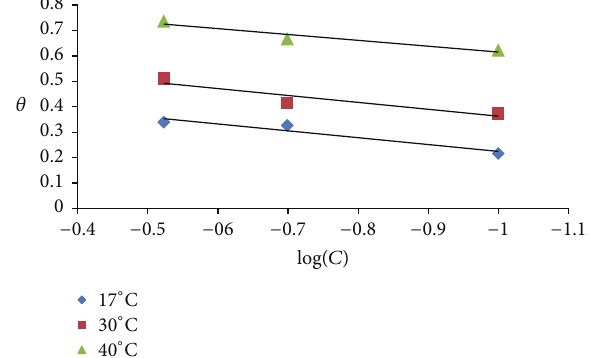
Figure 5: The surface coverage ( 𝜃 ) against the log of 𝐶 GA at various temperatures.